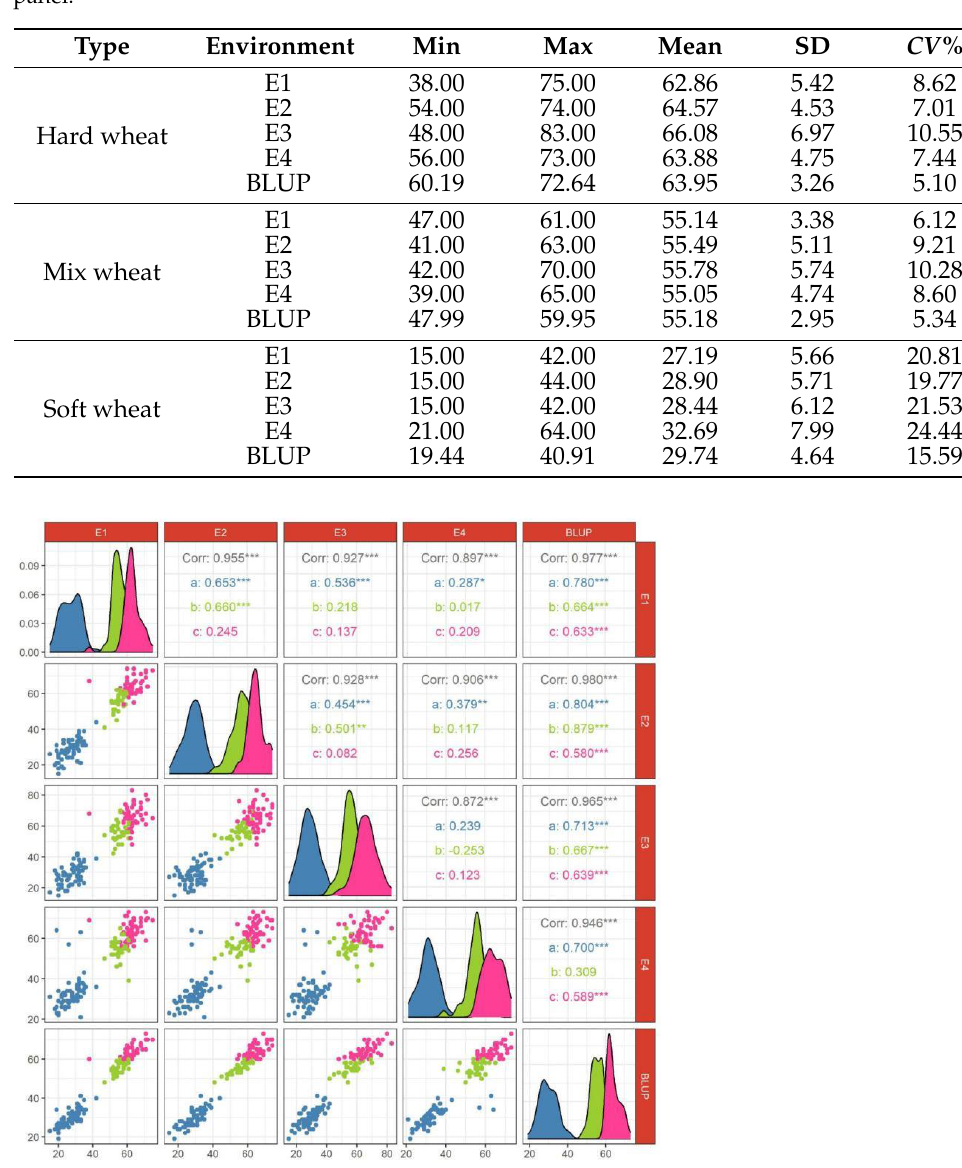
Figure 1. Correlation of soft wheat, mixed wheat, and hard wheat in different environments. Note: a: soft wheat; b: mixed wheat; c: hard wheat. The curves represents normally fitted distribution plots for different kinds of wheat. *: Significant at p < 0.05; **: Significant at p < 0.01; ***: Significant at p <